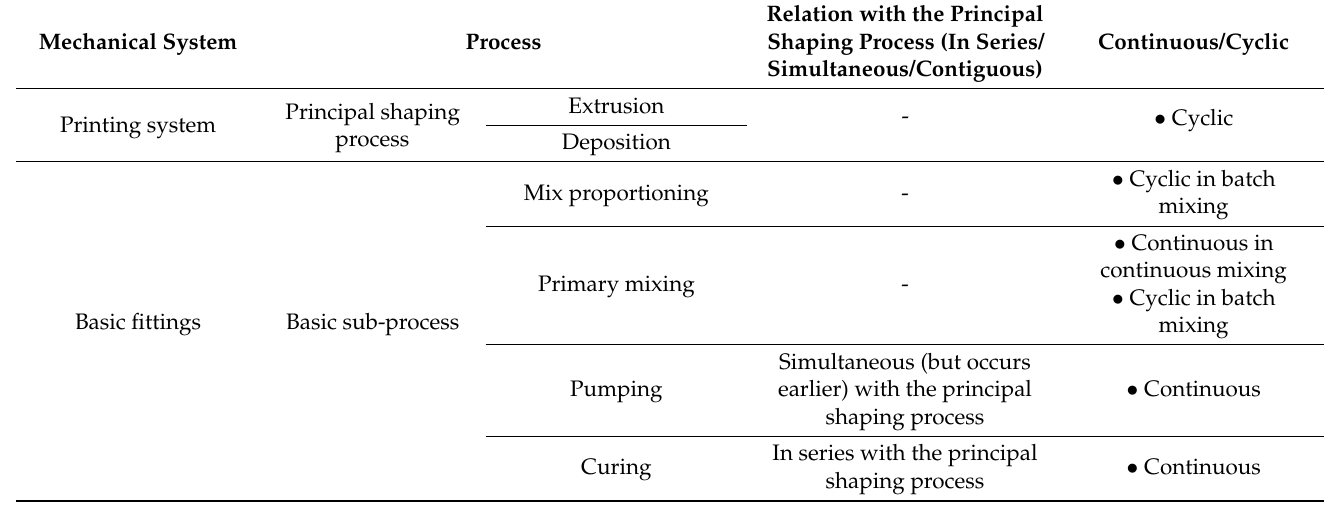
Table 9. The relation between and nature of the E3DCP principal process and